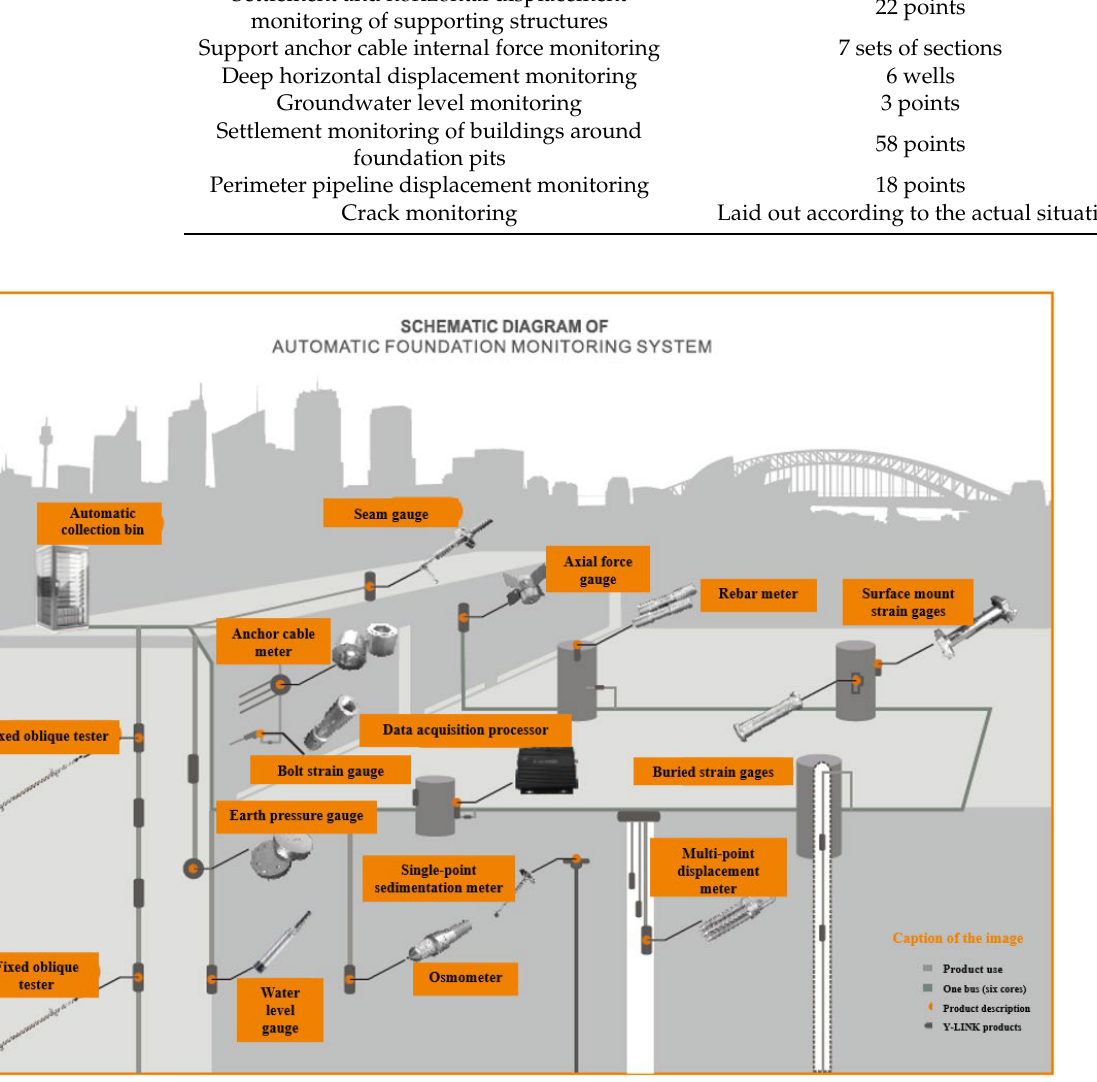
Figure 8. Schematic diagram of foundation pit online monitoring system.